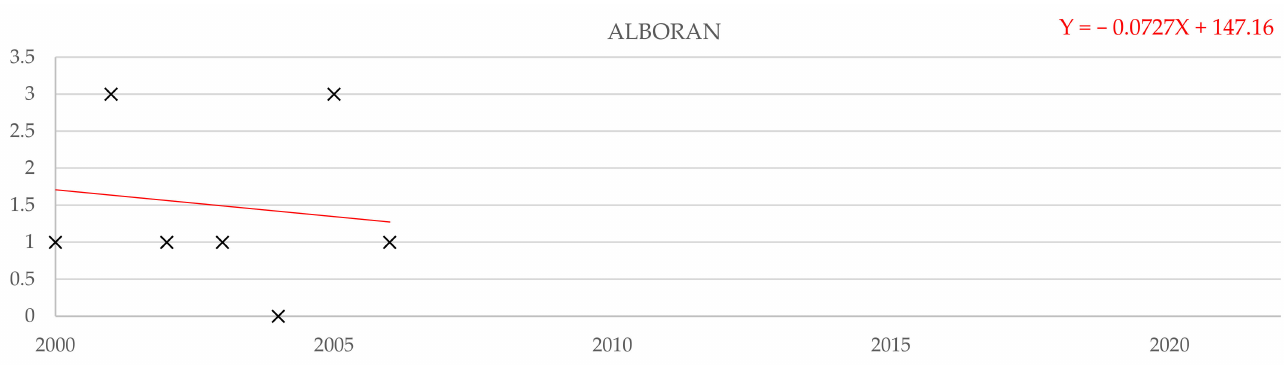
Figure 27. Number of times Tp has exceeded the expected Tp in 100 years in the Gulf of Cadiz.